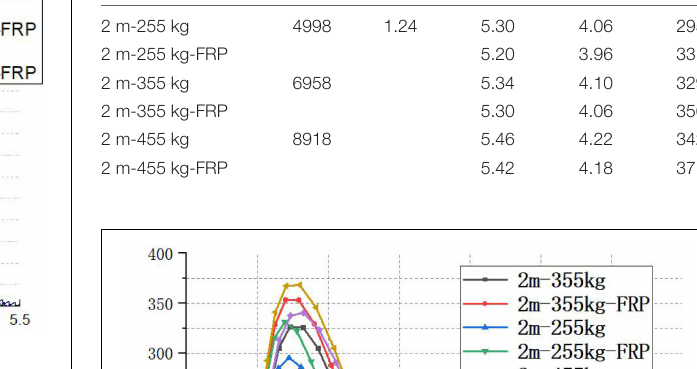
FIGURE 18 | Impact force time history curves at different weights.